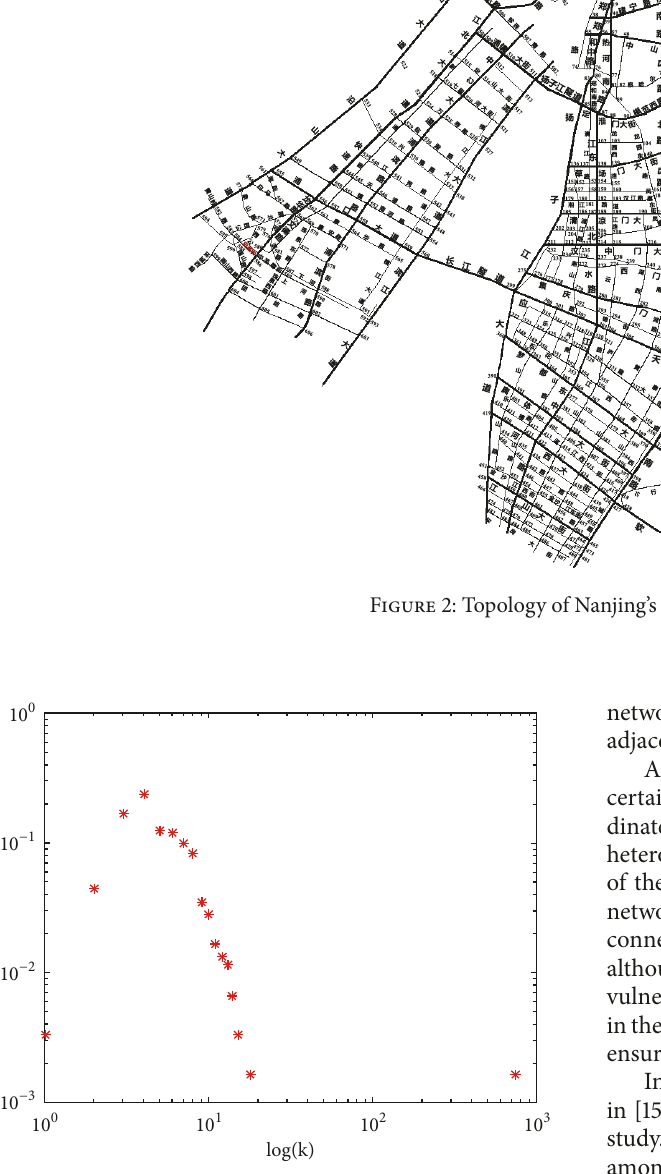
Figure 3: Degree distribution of